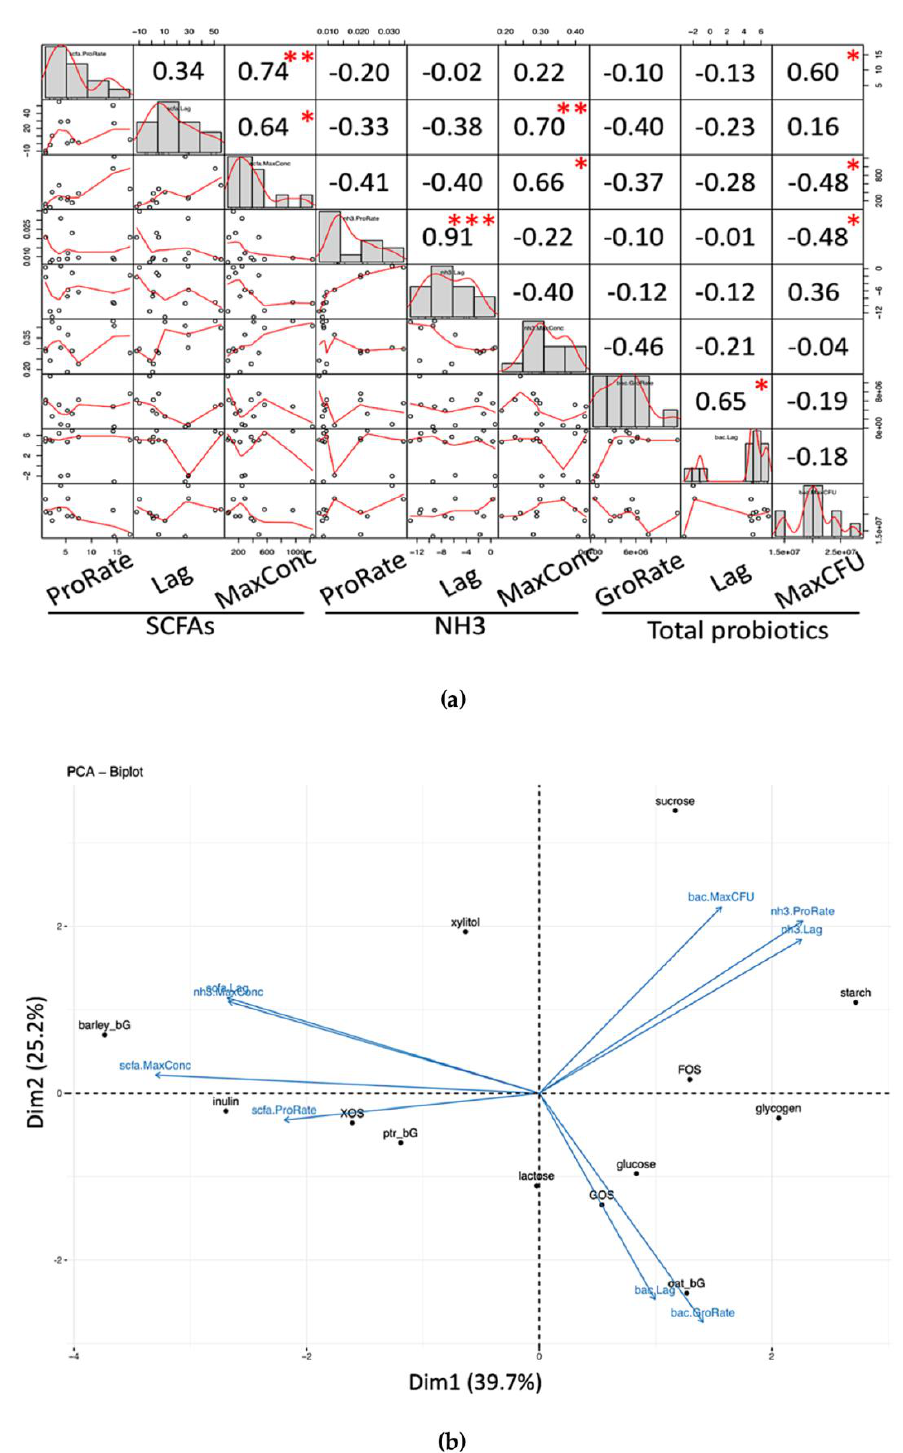
Figure 6. Pearson’s correlation of parametrically modeled parameters and PCA biplot for biological insights. ( a ) Pearson’s correlation of modeled parameters of total probiotic (bac) population pattern, total short-chain fatty acids (SCFAs) production pattern and dissolved ammonia (NH 3 ) production pattern. Numbers refer to the Pearson R-squared value while * denotes p -value < 0.05; ** denotes p -value < 0.01; and *** denotes p -value < 0.001. ( b ) Exploratory PCA biplot of the modeled parameters and the 13